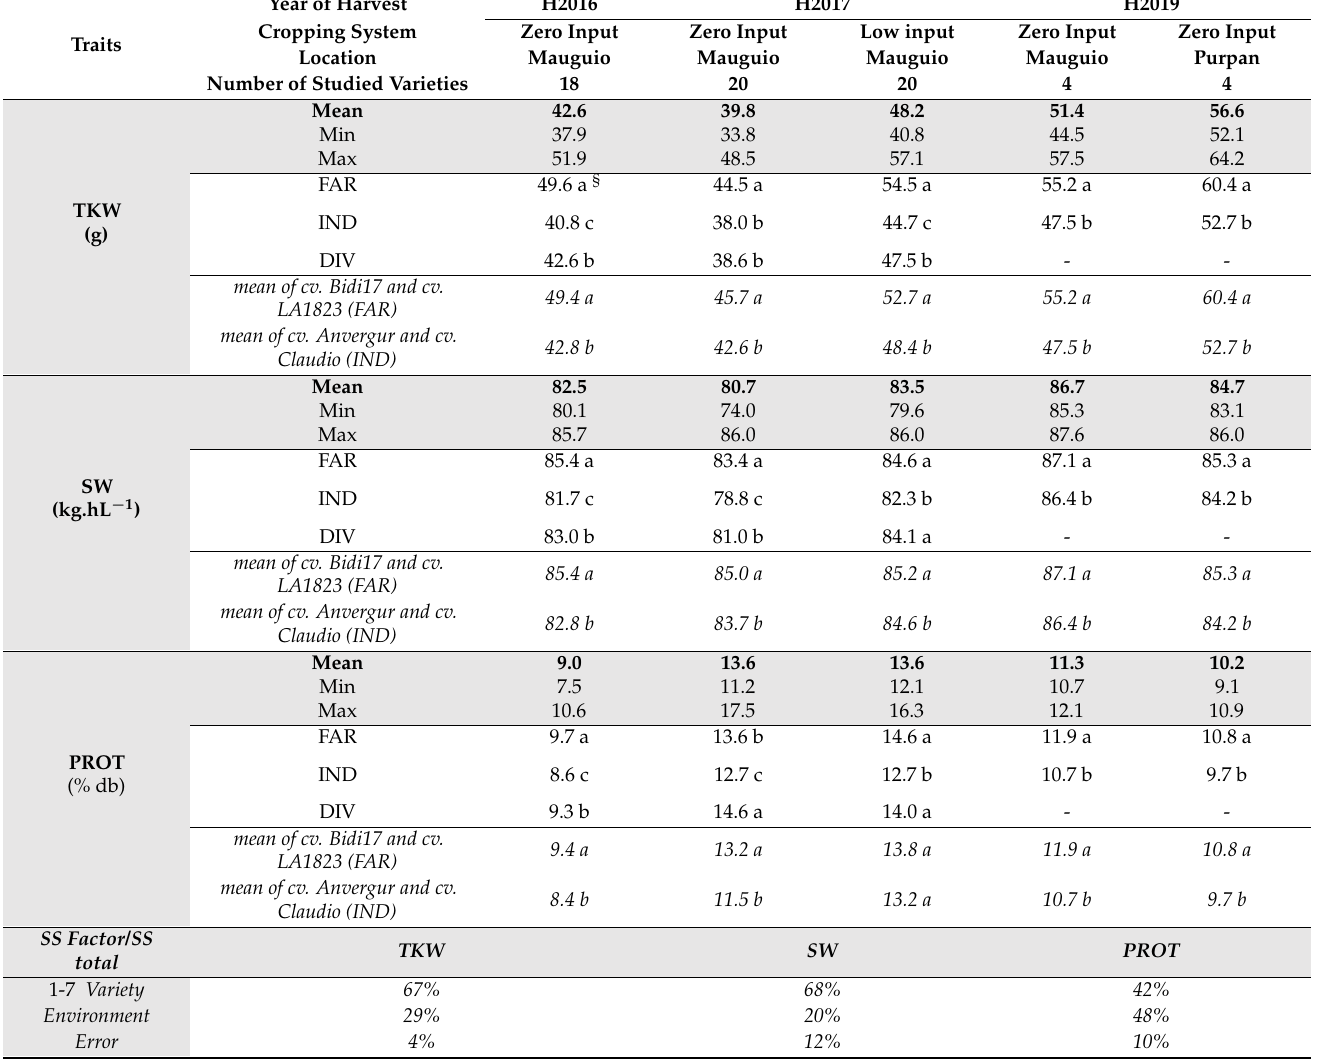
Table 3. Average of the thousand-kernel weight (TKW), specific weight (SW) and protein content (PROT) measured on durum wheat whole grains by NIRS method, according to the year, the cropping system and the location. Varieties used by farmers (FAR), varieties recommended by industry (IND), other varieties (DIV). Contribution (%) of each factor (variety and environment) to the variability of the criteria TKW, SW and